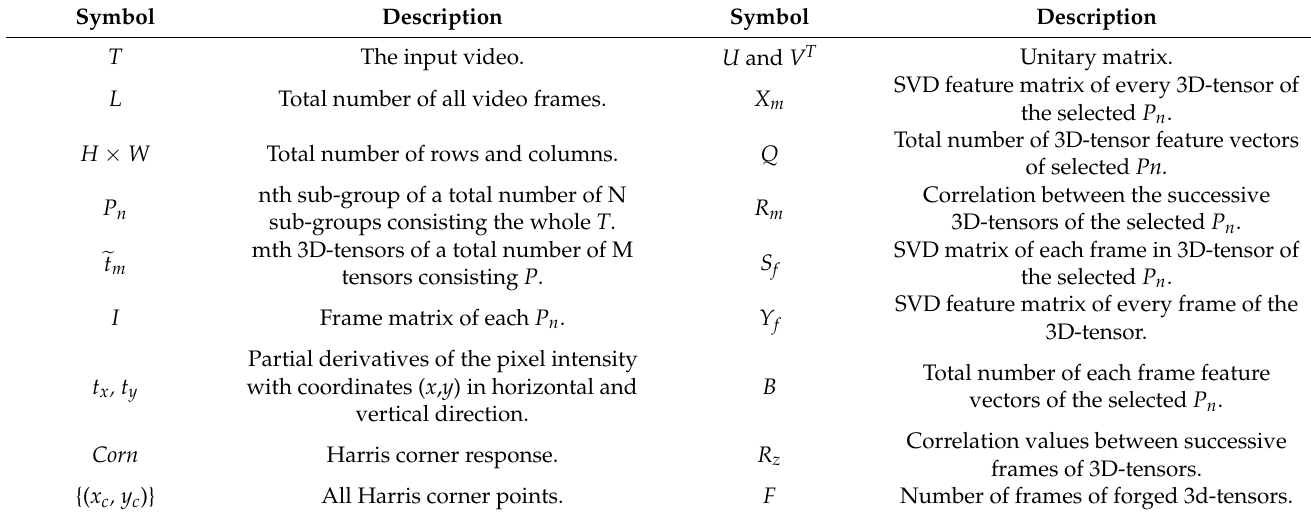
Table 2. List of Symbol